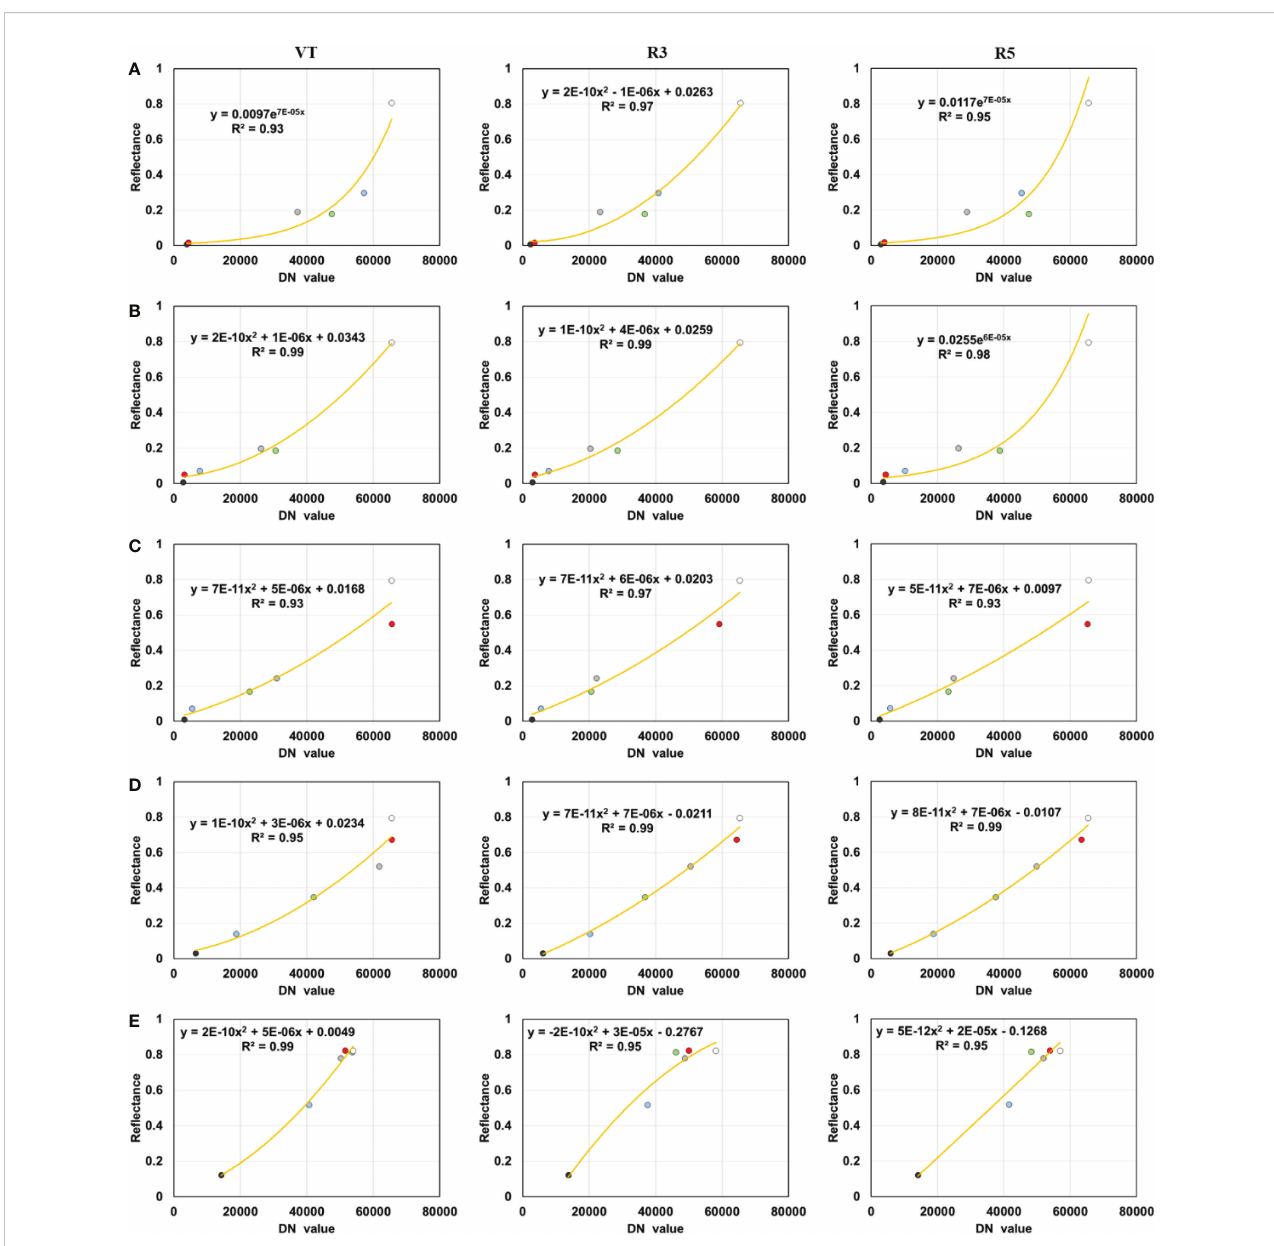
FIGURE 4 Multispectral radiometric calibration fi tting models. (A) blue band, (B) green band, (C) red band, (D) red-edge band, and (E) near-infrared